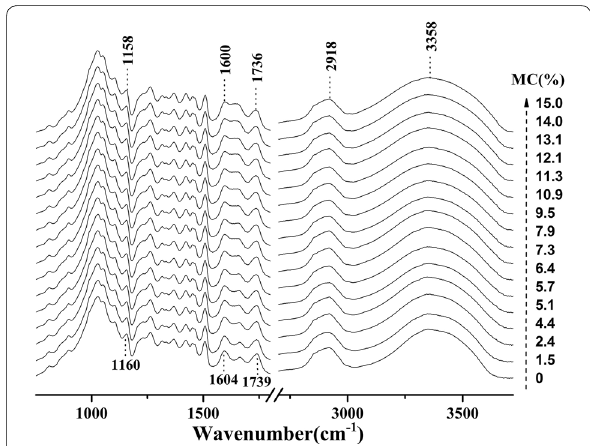
Fig. 4 Heat-treated wood spectra collected during the moisture adsorption process Fig. 5 Difference spectra collected in the MC range from 1.5 to